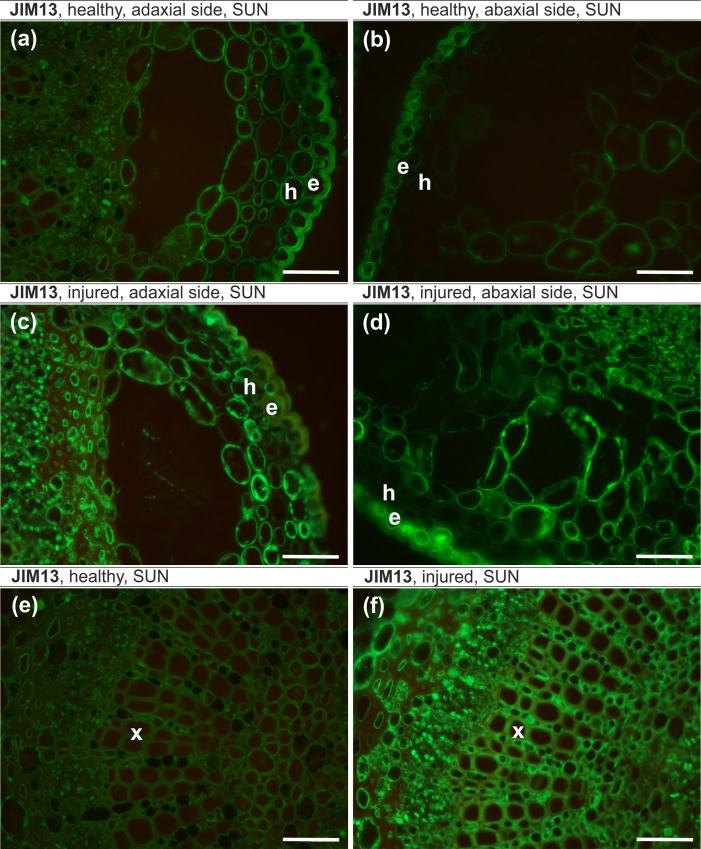
JIM13 epitope, sunlit side.(a,b,e) – healthy leaves, (c,d,f) – injured leaves, (a,c) – adaxial side, (b, d) – abaxial side. e – epidermal cells, h – hypodermal cells, x – xylem cells. Bars, 50 μm.